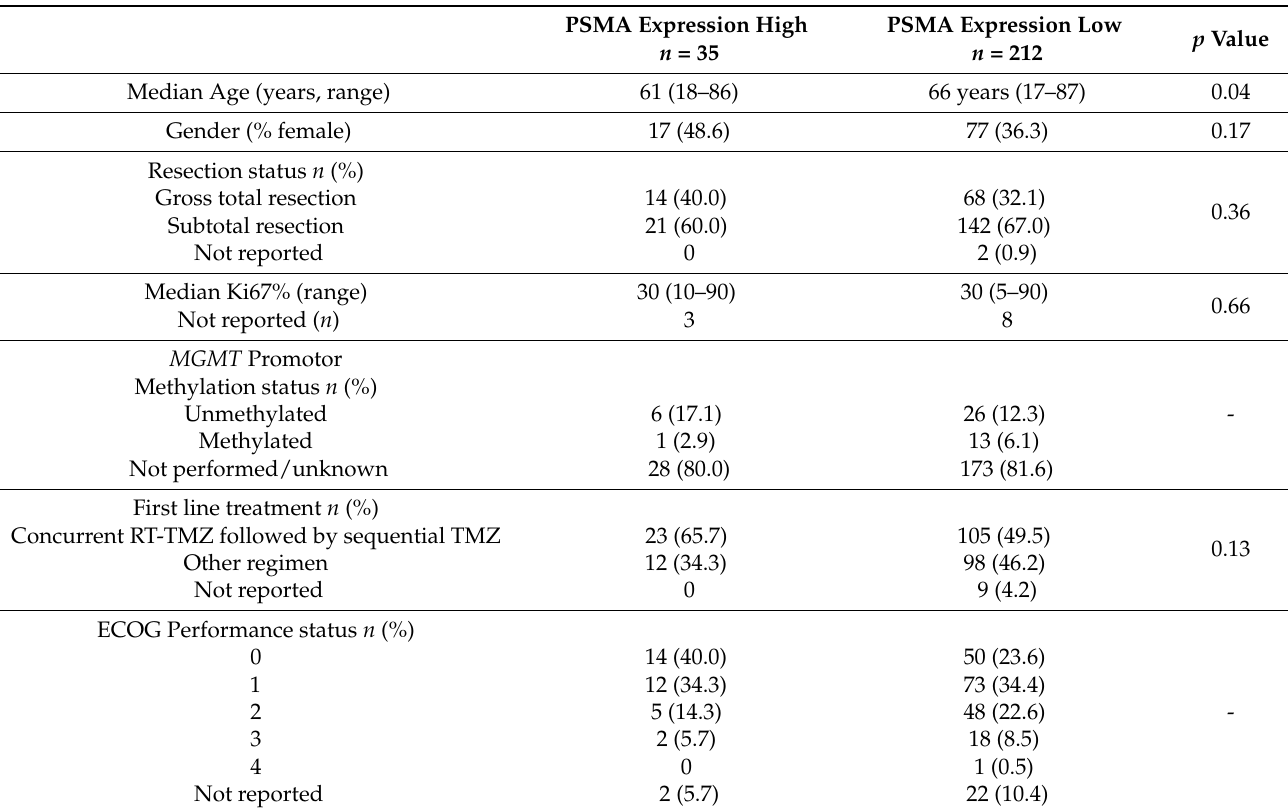
Table 1. Patient characteristics. RT- radiotherapy; TMZ- temozolomide; ECOG- Eastern Cooperative Oncology